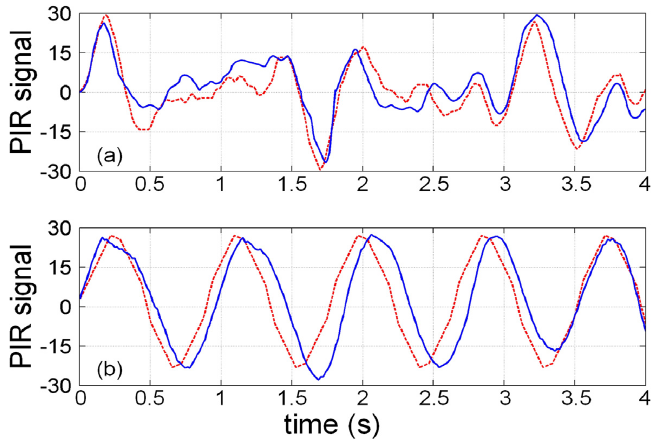
Figure 3. Real (blue-solid) and simulated (red-dashed) PIR signals of adult ( a ) and dog ( b ).